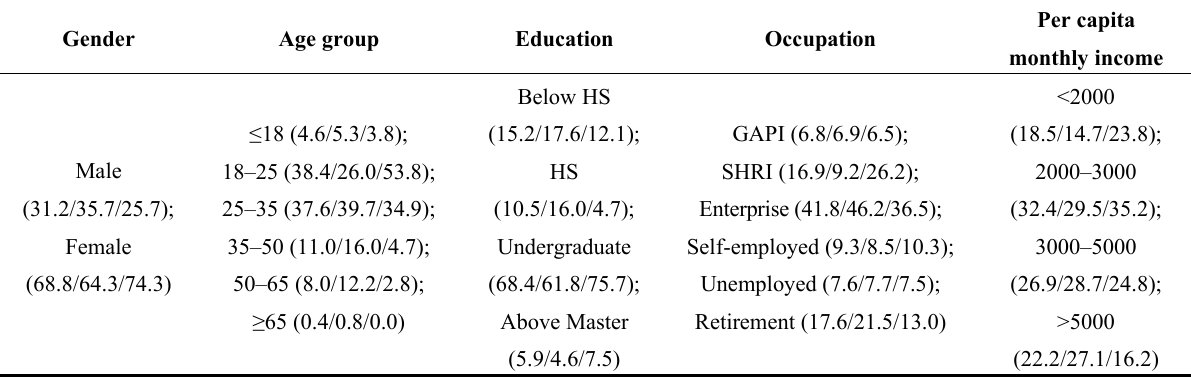
Figure 3. ( a ) Shoppers distribution on weekdays; ( b ) Shoppers distribution on weekends. Table 2. Characteristics of Zhongjie shoppers (Total/Weekday/Weekend